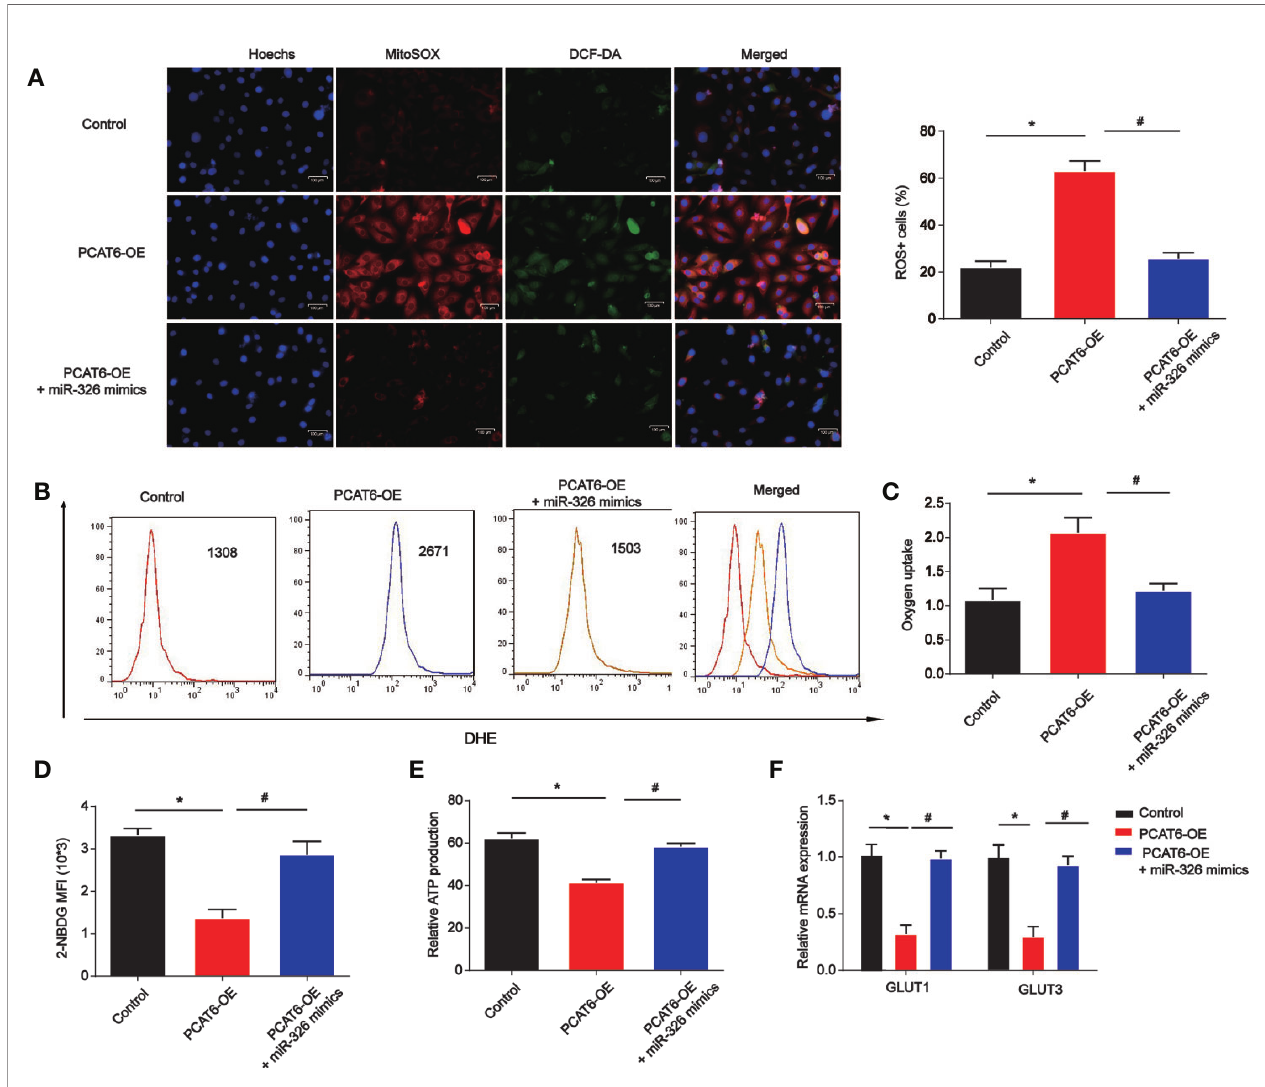
FIGURE 6 | The overexpression of PCAT6 contributed to the accumulation of ROS, mitochondrial and metabolic dysfunction in macrophages. THP-1-diferentiated macrophages were infected with PCAT6 overexpression plasmid and miR-326 mimics. (A) Immuno fl uorescence with DCF-DA and MitoSOX staining were used to detect the levels of cytoplasmic and mitochondrial ROS. ROS+ cells were observed under microscopy. Scale bar, 100 m m. (B) The levels of DHE in macrophages were analyzed using fl ow cytometry. (C) Oxygen uptake rate in macrophages. (D) The levels of 2-NBDG were analyzed using fl ow cytometry in macrophages. (E) Relative ATP levels of the THP-1-diferentiated macrophages. (F) The messenger RNA (mRNA) levels of Glut1 and Glut3 were tested by qRT-PCR. *P < 0.05. Compared with the control group. # P < 0.05. Compared with the PCAT6 OE